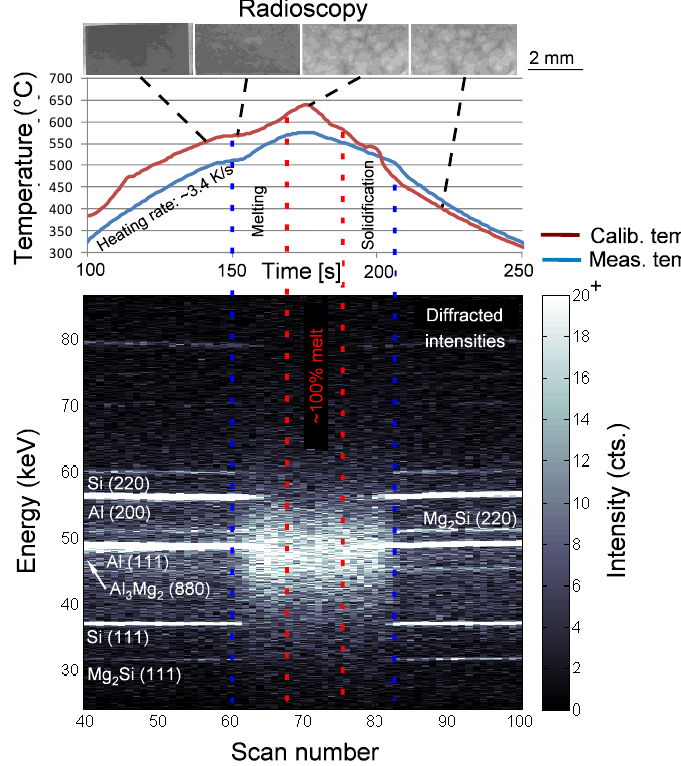
Figure 8. Density maps of diffracted intensities (grey scale) dispersed in energy (in keV) versus time correlated to the scan number and to the temperature profile and selected radioscopic images of an evolving AlSi8Mg4 foam.